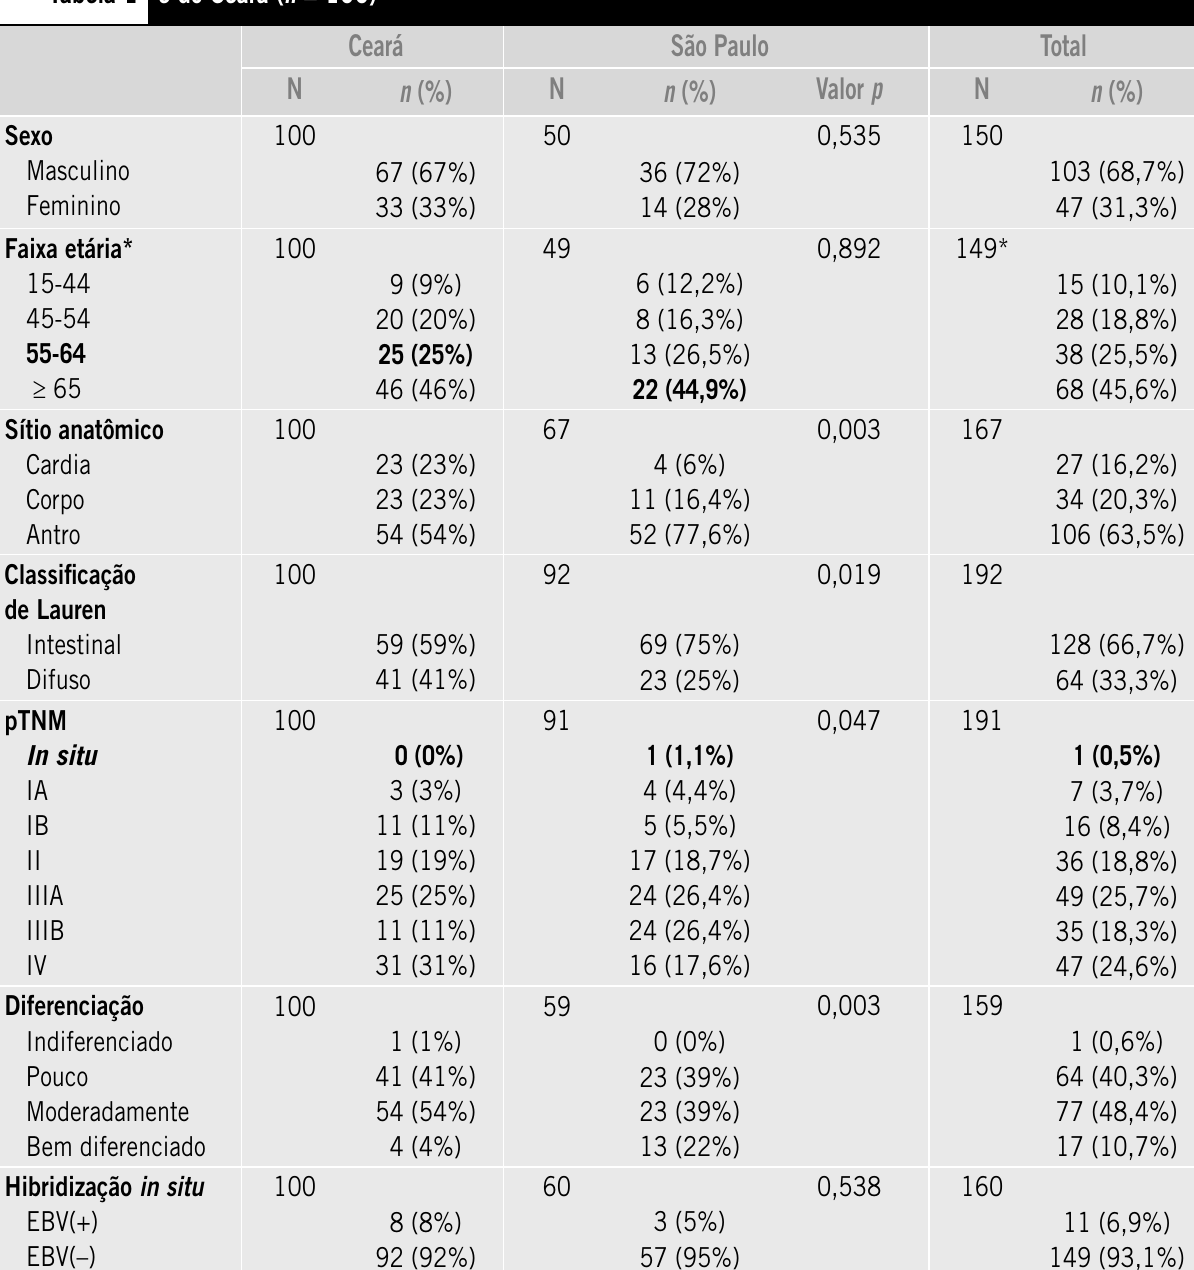
Comparação de dados clinicopatológicos e detecção de EBV entre os casos de São Paulo ( n = 92) e do Ceará ( n =